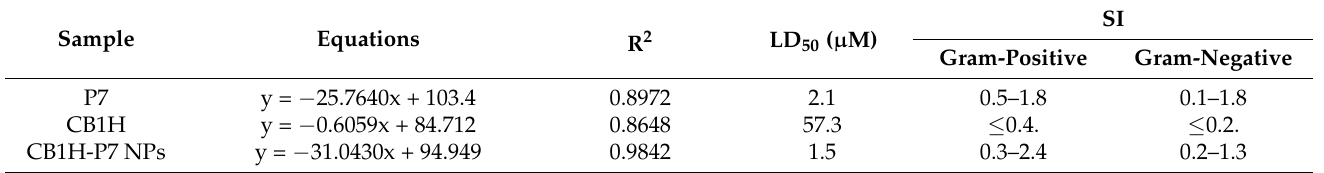
Table 7. Regression equations, R 2 values, LD 50 of empty P7, pristine CB1H and CB1H-P7 NPs, as well as the relative SI ranges calculated using Equation